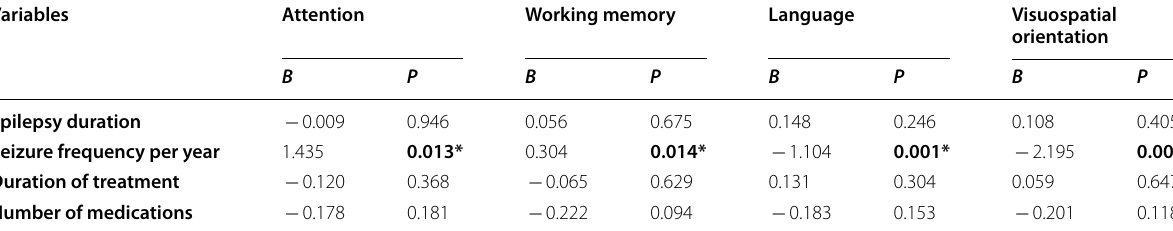
P indicates the P value for comparing between different categories * Statistically significant at P ≤